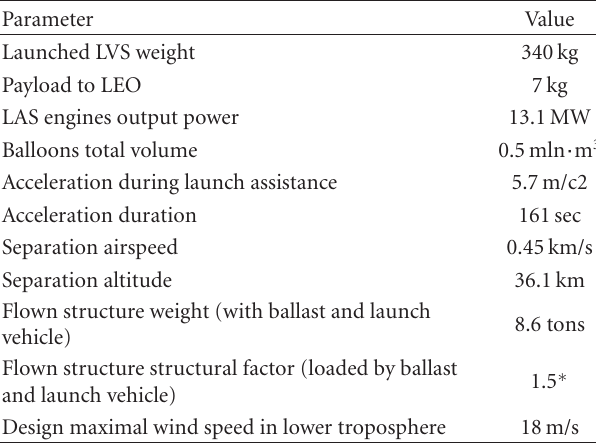
Table 4: Life-cycle budget of the proposed LAS/LVS system.